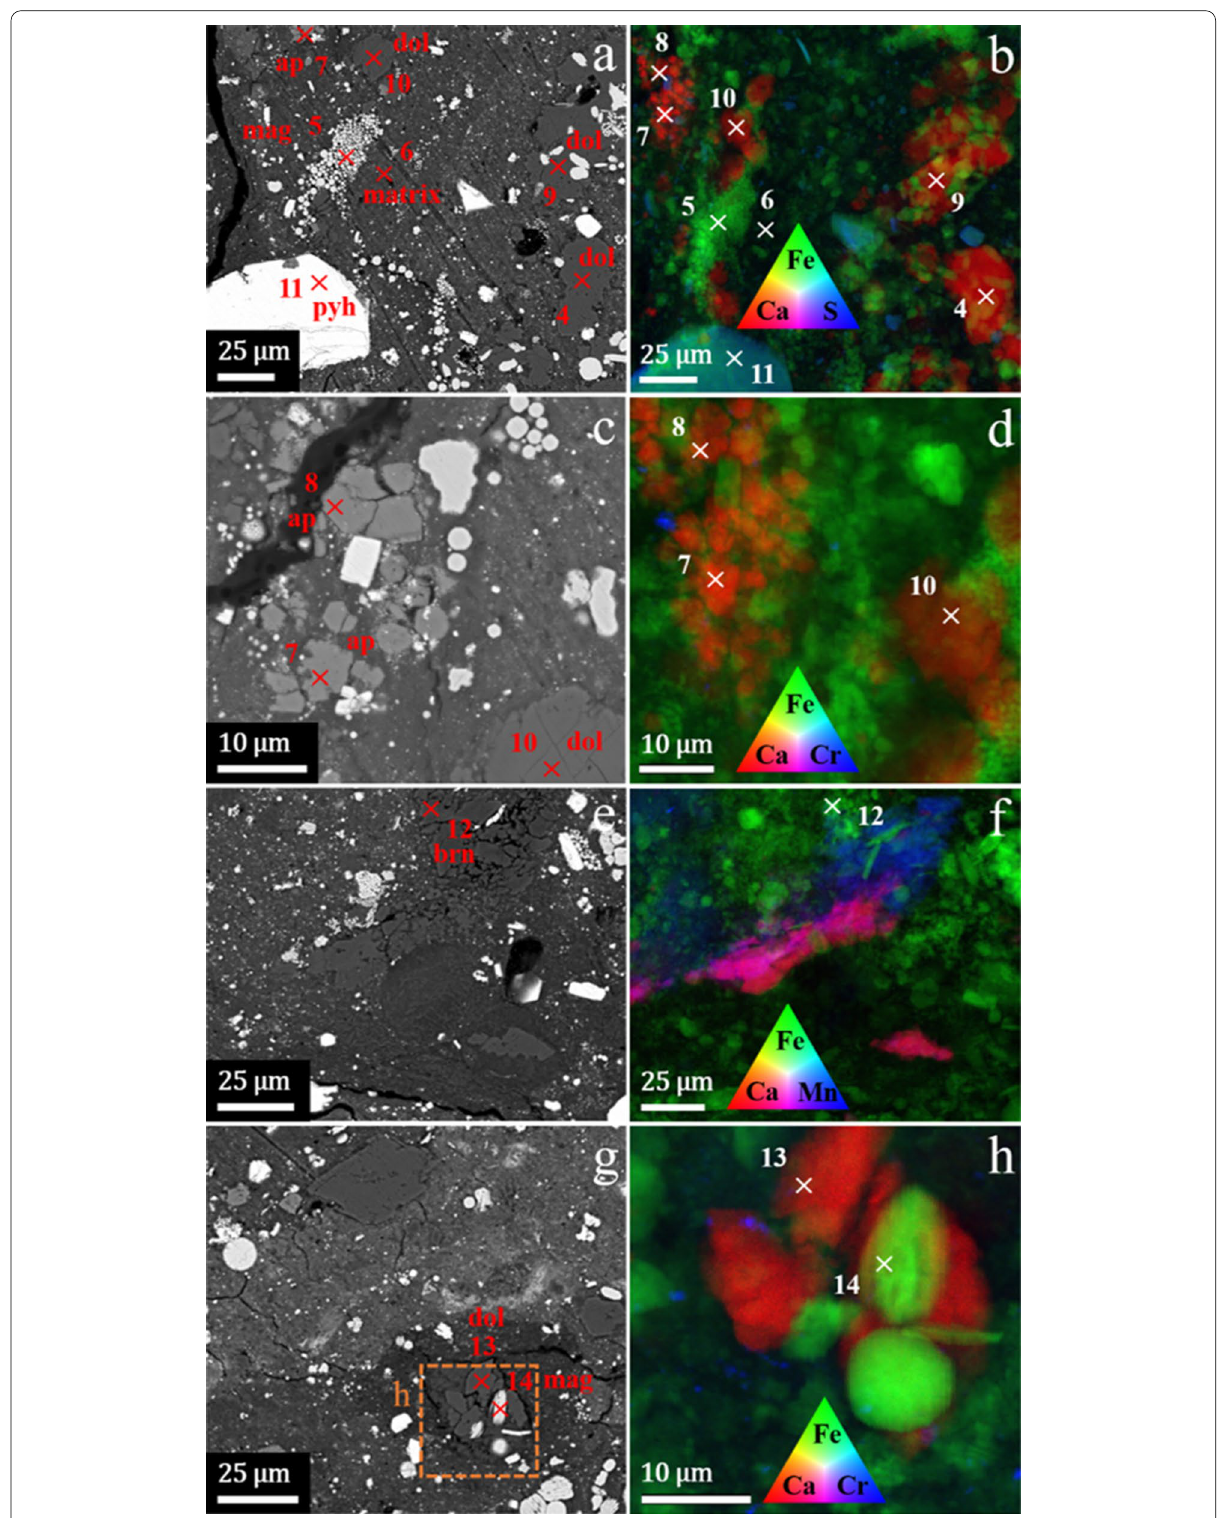
Fig. 4 (See legend on previous